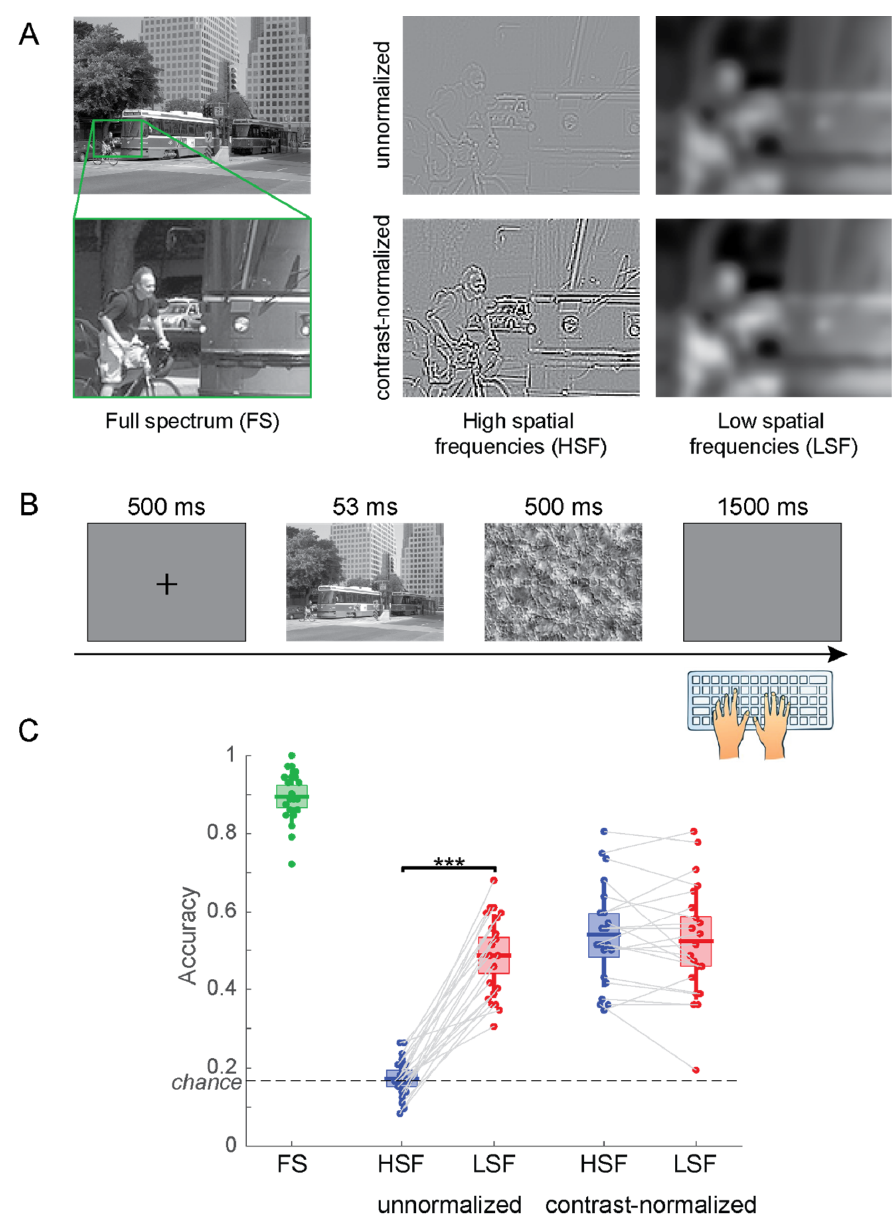
Figure 3. ( A ) Example stimuli for Experiment 1. To better illustrate the effects of the filtering choices, we display enlarged sections of the actual stimuli. ( B ) Time course of the experiment. ( C ) Accuracy of scene categorization for the five types of stimuli. The center lines of the boxes indicate the mean, the extent of the box the standard error of the mean, and the whiskers the standard deviation of the individual data